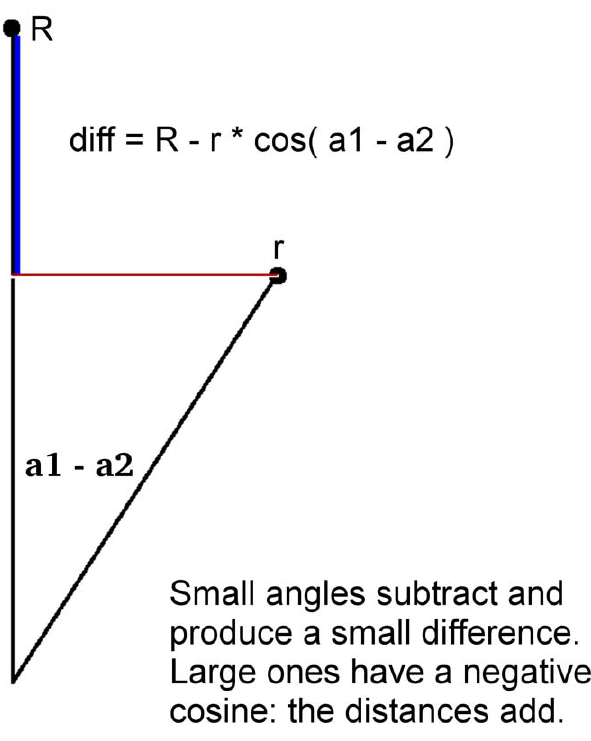
Figure 7. Difference measure for W-curves stored in Cylindrical notation. Subtracting the projection of the smaller radius onto the larger one smooths out small differences after the curves have largely converged. For small angles (shown) the projection is subtracted and produces a small difference. As the angle increases the projection becomes small; points in opposite quadrants have obtuse angles with a negative cosine, adding the projection onto the larger radius.